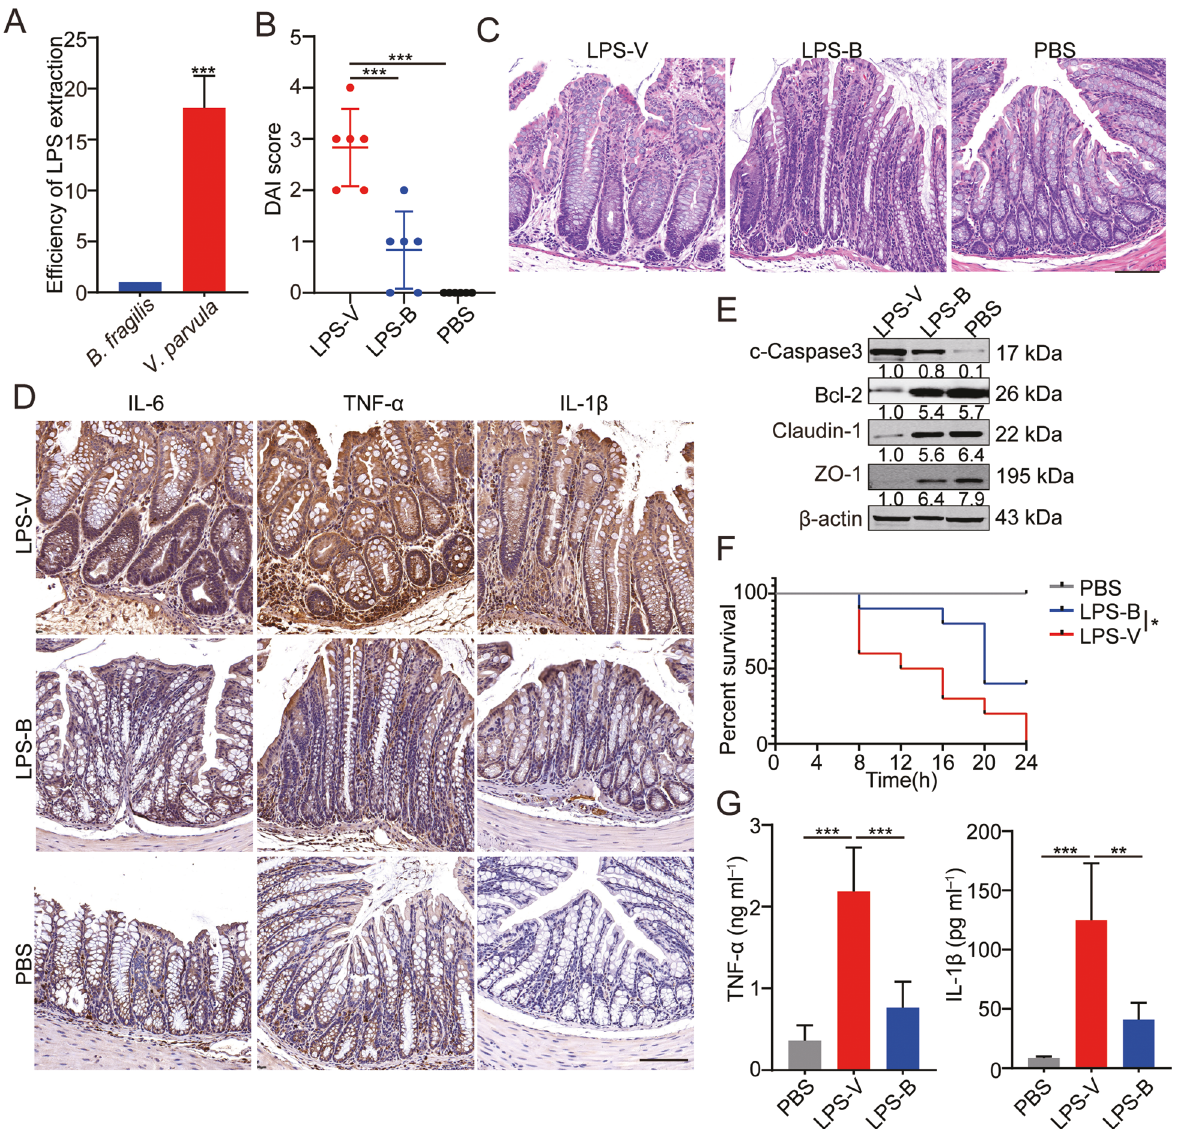
Fig. 2 The high toxic effects of LPS from V. parvula in vivo. A The ef fi ciency of LPS extraction from V. parvula and B. fragilis . B The disease activity index (DAI) of mice in V. parvula group is higher than that in B. fragilis or PBS group. C Representative photomicrographs showing worse histologic injury as well as more crypt abscesses and more distribution of immune cells in the distal colon of mice fed with LPS. Scale bars: 100 μ m. D Higher levels of in fl ammatory cytokines (IL-6, IL-1 β , and TNF- α ) in distal colon of mice treated with LPS-V. E Western blotting assays showing more apoptosis and impaired tight junction induced by LPS-V than LPS-B or PBS in distal colon tissues. F Survival in mice ( n = 10 mice/group) treated with LPS-V is shorter compared to mice treated with LPS-B or PBS in an LPS model of sepsis. G Serum concentration of pro-in fl ammatory factors in three groups. All data are expressed as mean ± SD. NS denotes no signi fi cation. * P < 0.05; ** P < 0.01; *** P <